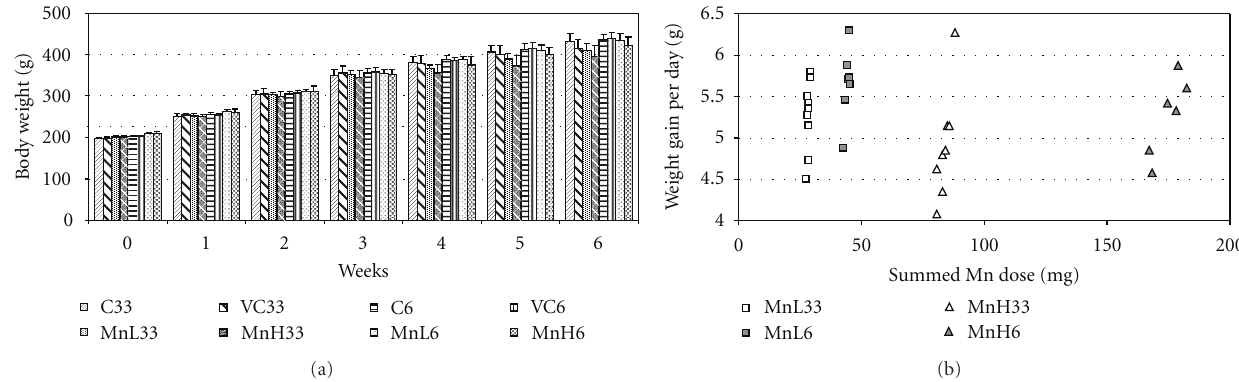
Figure 1: (a) Time course of the control and treated rats’ weight gain in the 3 weeks oral + 3 weeks intratracheal and the 6 weeks oral treatment. Mean ± SD, n = 8. Significance marking omitted for clarity; for this, see Table 2. (b) Relationship of summed Mn dose (abscissa) and daily weight gain (ordinate) of individual rats belonging to the treatment groups given in the insert. Daily weight gain was calculated by dividing total weight gain with the length of treatment.